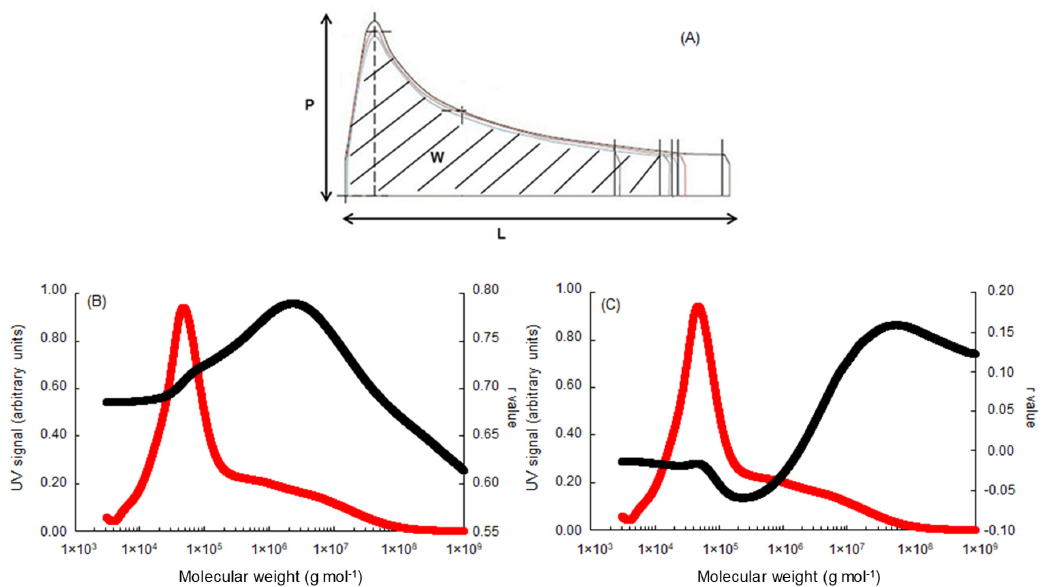
Figure 3. Representation of the different alveogram parameters used ( A ) and plot of simple linear correlation coefficients ( n = 780) between A4F data (weight-average molecular mass, Mw): W ( B ) and P/L ( C ). The UV signal (214 nm), which is represented by the red line, corresponds to the mean fractogram of the 130 wheat genotypes studied.